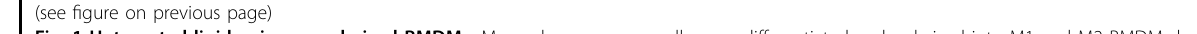
Fig. 1 Untargeted lipidomics on polarized BMDMs. Mouse bone marrow cells were differentiated and polarized into M1 and M2 BMDMs by treatment of LPS and IL-4, respectively. Lipids were extracted from non-polarized and polarized BMDMs and their CM, then subjected to untargeted lipidomics analyses by UHPLC-ESI-MS/MS. A , B Content of individual lipid species in M0 or polarized BMDMs ( A ) and their CM ( B ). CER and SPH species were highlighted in red. C – F Lipid pro fi les of M0, M1, M2 BMDM cells and their CM were detected by untargeted lipidomics. PCA score plots and loading plots were used for exploratory data analysis of lipid dysregulation in BMDMs ( C and D ) and their CM ( E and F ) through dimensional reduction and data visualization. G , H Content of lipid classes in M0, M1, and M2 BMDMs ( C ) and their CM ( D ). I , J SUS-plot analysis based on orthogonal projections to OPLS-DA on lipid classes in polarized BMDMs ( I ) and their CM ( J ). Data represent results from three samples, each was pooled using BMDMs isolated from three mice. Data in G and H represent mean ± SD; * p < 0.05, ** p < 0.01, *** p <